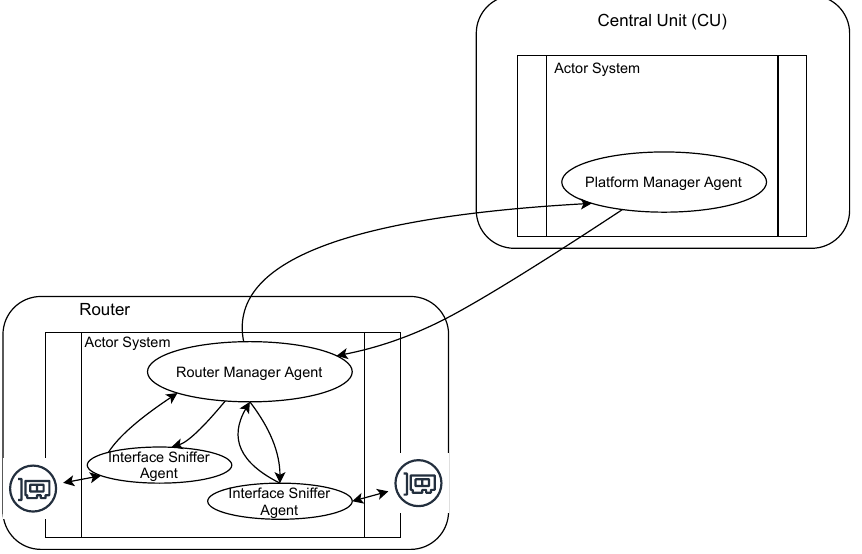
Figure 1. Scheme of monitoring platform based on actor system